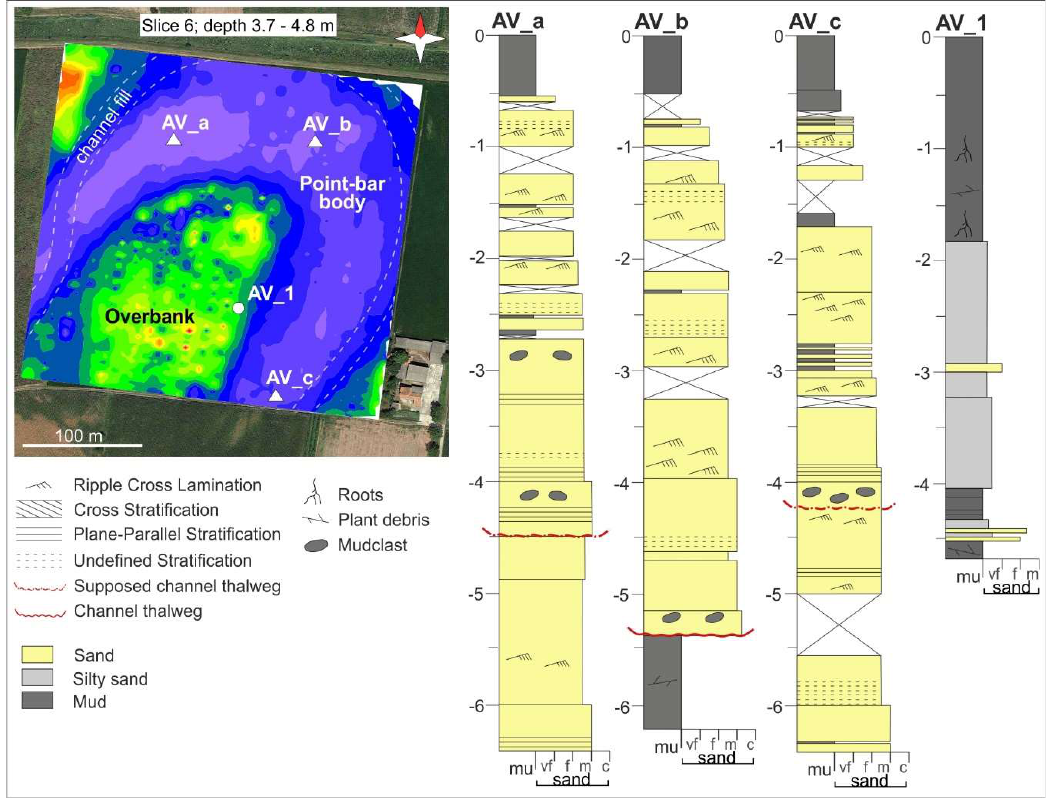
Figure 7. Sedimentary features of cores for bar and overbank deposits at the study site. Location of cores is shown with the conductivity for Slice 6.